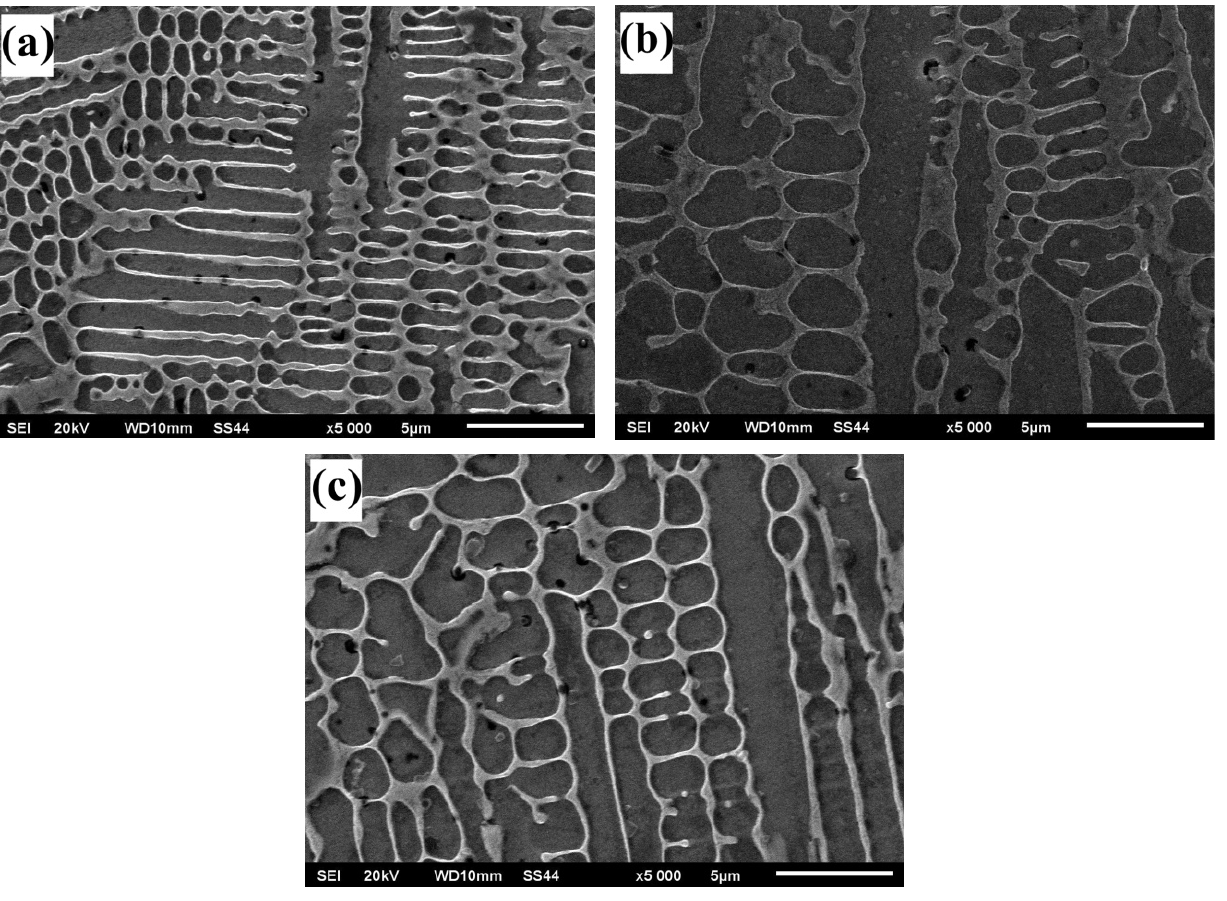
Figure 10. Microstructure of the central part of the alloyed zone for ( a ) sample 1; ( b ) sample 2; ( c ) sample 3.